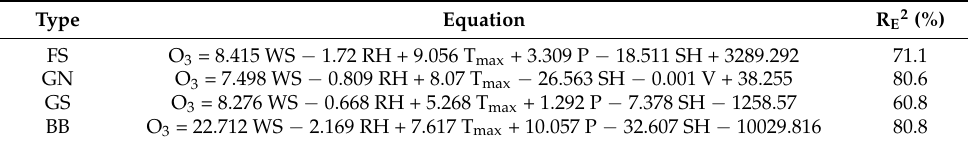
Table 4. Equations of the stepwise MLR for each SWP in PT during the springtime of 2015–2020.